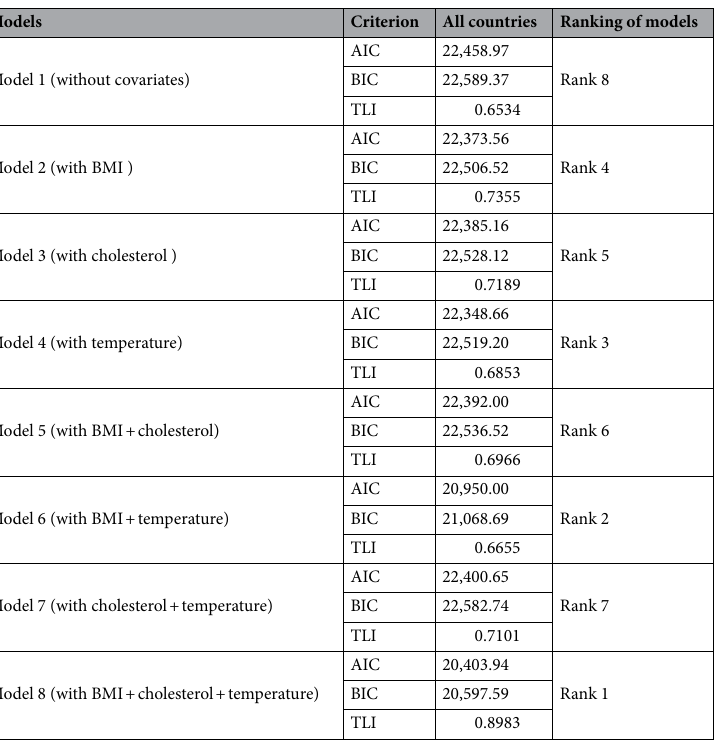
Table 2. Multiphase model determining the correlation between different covariates. AIC Akaike information criterion, BIC Bayesian information criterion, TLI Tucker–Lewis Index.